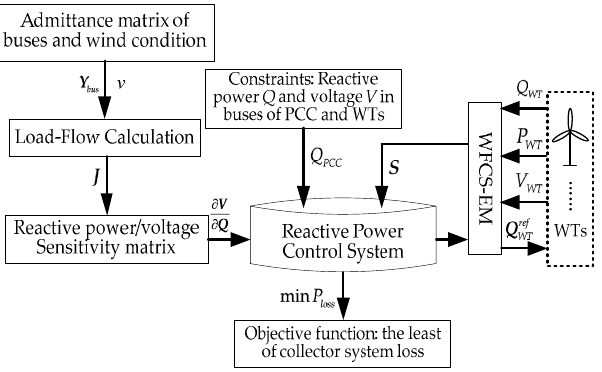
Figure 1. Proposed reactive power control system.